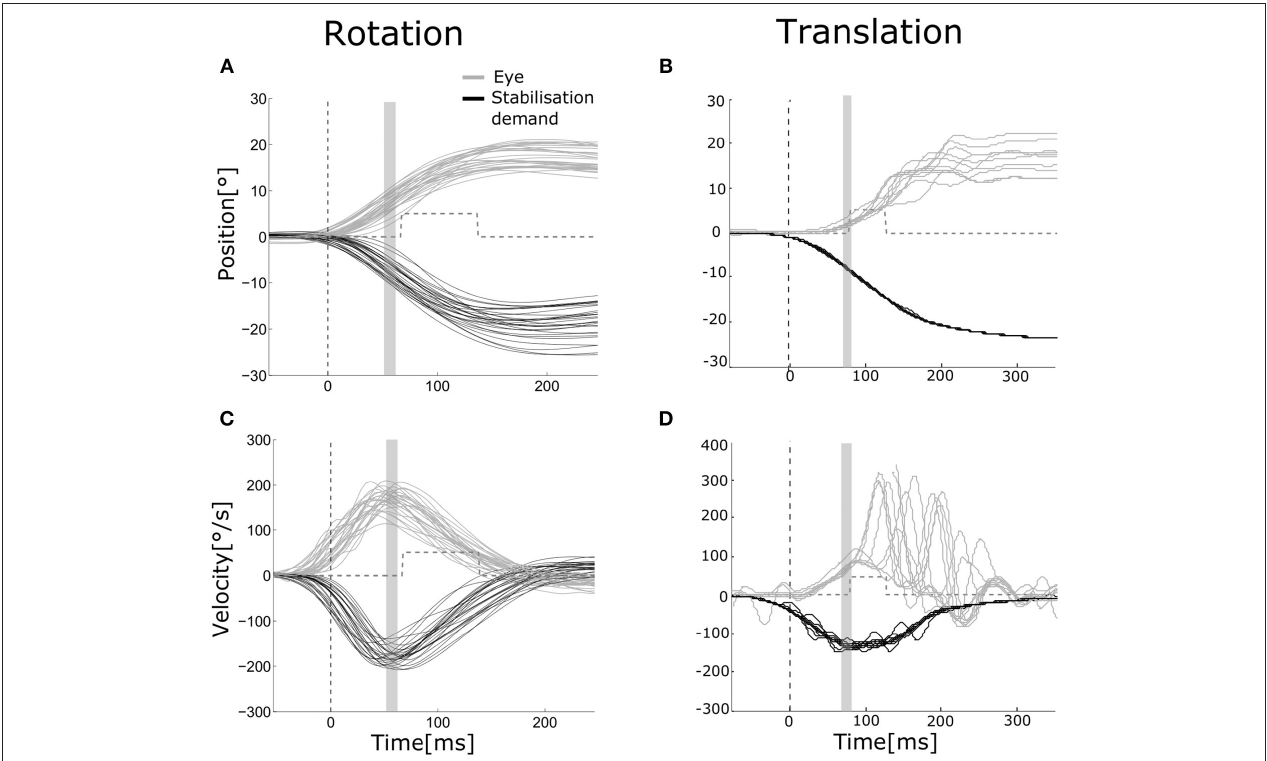
FIGURE 2 | Eye and head movements during rotation and translation Eye movement (gray) plotted vs. stabilization demand (black) for a representative subject during rotation [ (A,C) head and eye movements to the left and to the right pooled, left eye] and translation [ (B,D) movements to the right, right eye]. Position (A,B) and velocity (C,D) traces are aligned to stimulus presentation beginning. The dashed vertical line indicates the mean head movement start. The gray area indicates the time interval over which position and velocity gains of the VOR were computed (55–65ms after movement onset). The gray dashed line shows the mean time interval when the visual stimulus was turned on to assess dynamic visual